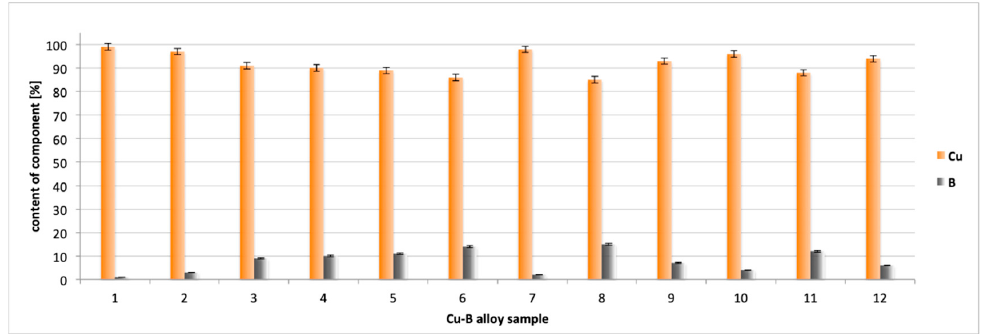
Figure 14. Concentration of components in the samples obtained during electrochemical